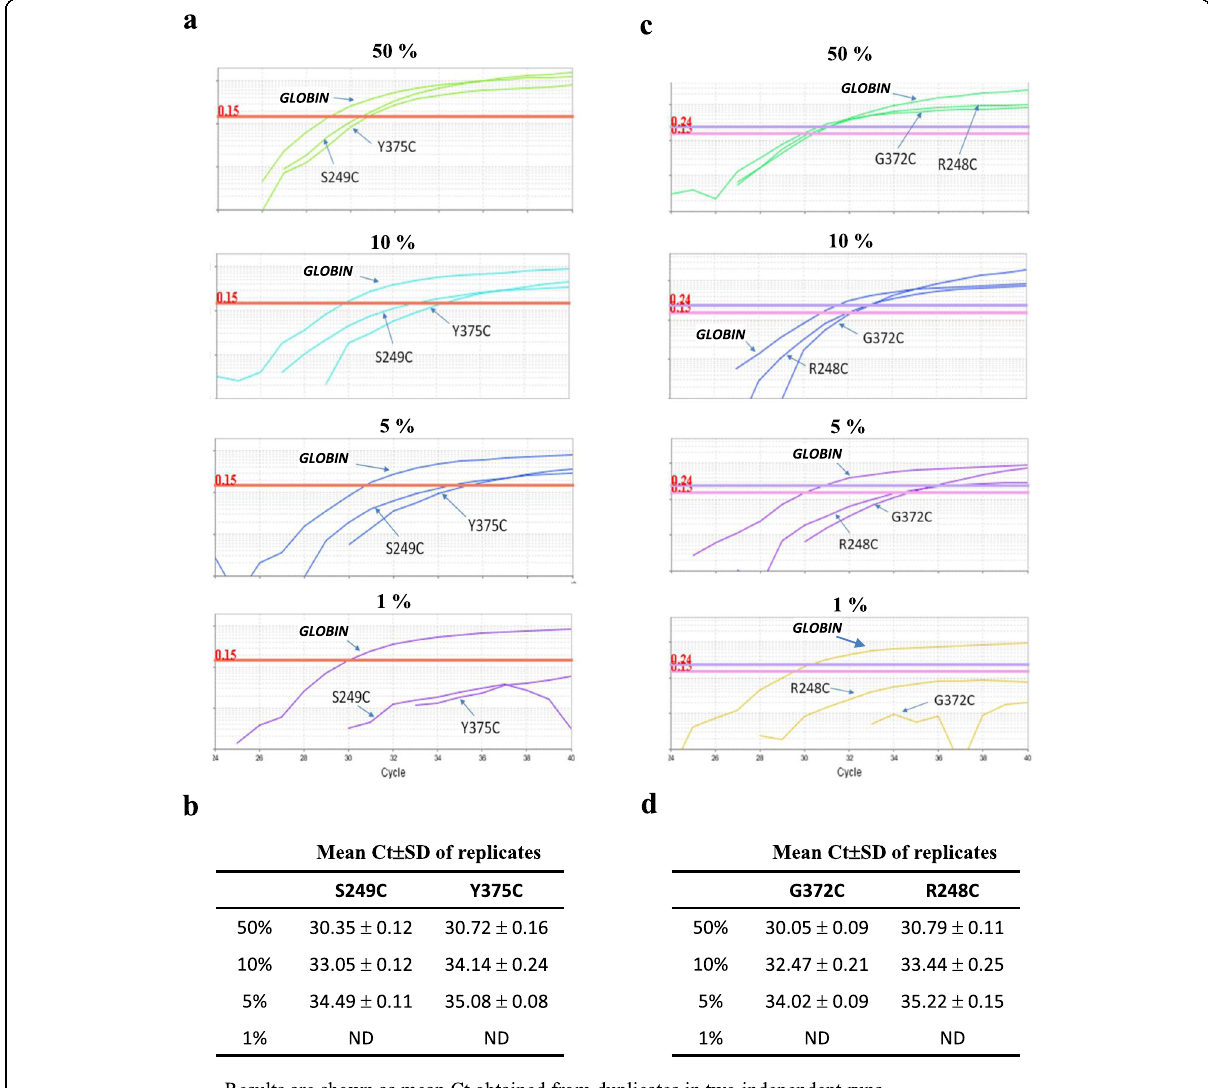
Fig. 3 LoD for the Mutation assay. DNA from FGFR3 mutant plasmids was diluted into the wild-type DNA (standard human DNA). The proportion of mutant DNA was 50, 10, 5, and 1%, respectively. The representative amplification curves ( a , c ) and mean Ct values ( b , d ) are shown in the detection of the FGFR3 S249C/Y375C (a, b) and R248C/G372C ( c , d ) mutations by